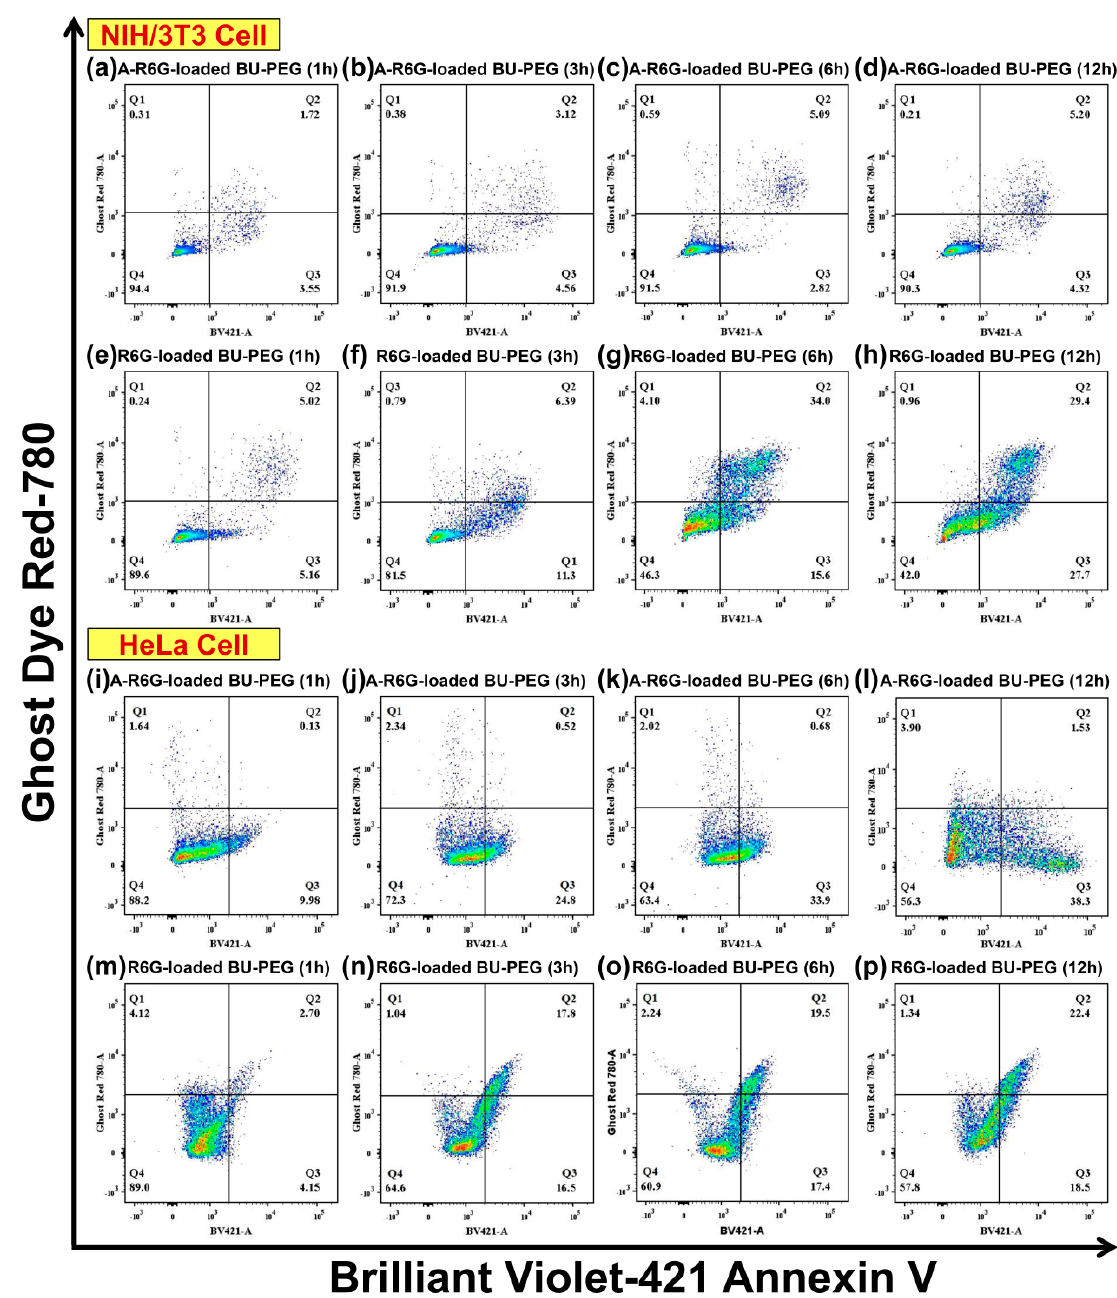
Figure 6. Flow cytometric dot plot quadrant charts of NIH/3T3 and HeLa cells cultured with A-R6G-loaded and R6G-loaded BU-PEG nanogels at normal physiological conditions (pH 7.4 and 37 °C) for 1, 3, 6, or 12 h before staining with BV421 Annexin V and GDR780. Figures ( a )–( p ) represent the results of flow cytometry for different time points during the co-culture period. The graph quadrants from the lower left to the upper left (turning anti-clockwise) represent viable cells (BV421 Annexin V - , GDR780 − ), early apoptotic cells (BV421 Annexin V + , GDR780 − ), late apoptotic cells (BV421 Annexin V + , GDR780 + ), and necrotic cells (BV421 Annexin V − , GDR780 + ). The numbers inside each quadrant refer to the proportions of cells.